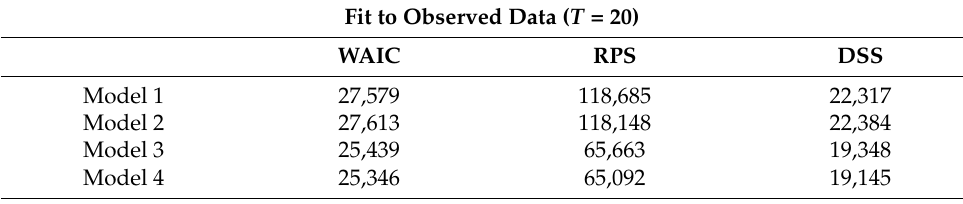
Table 3. Comparative Model Fit, Southeast England ( N = 144, T = 21).